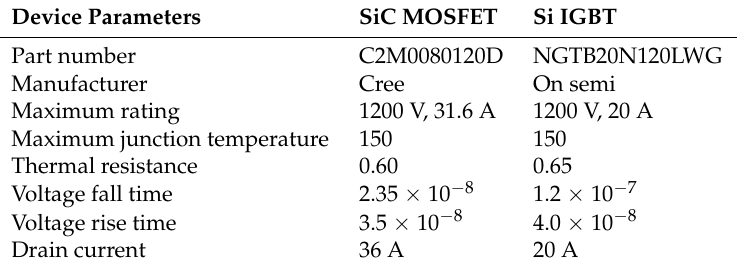
Table 2. Parameters of Power